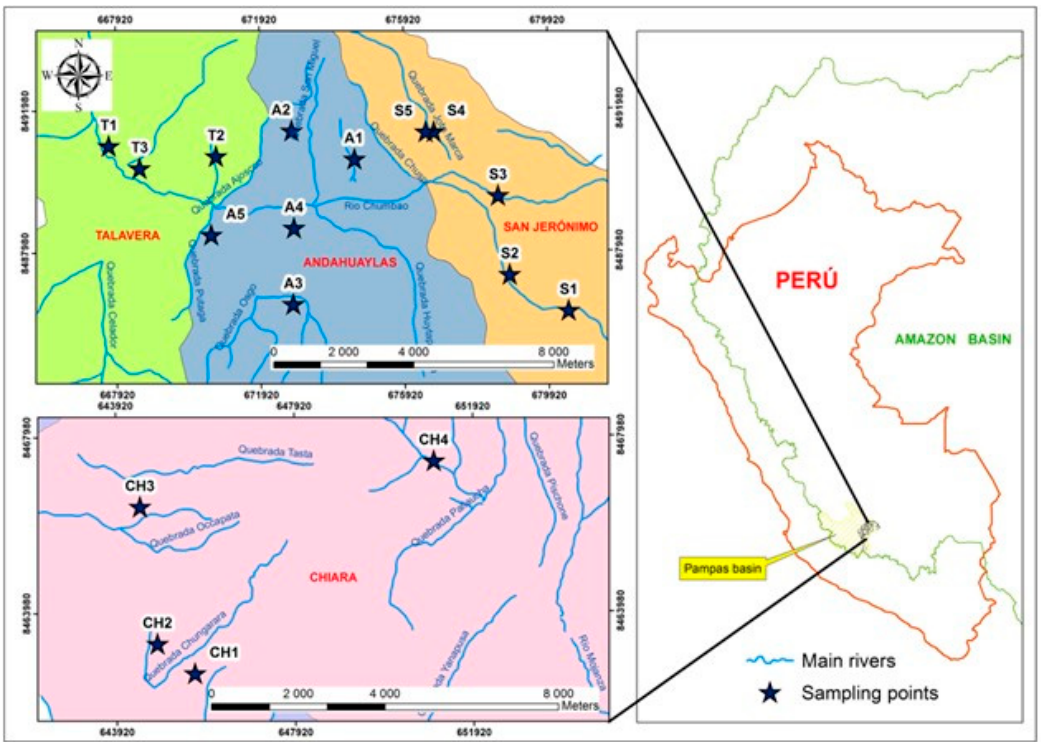
Figure 1. Distribution of sampling points in the study areas.